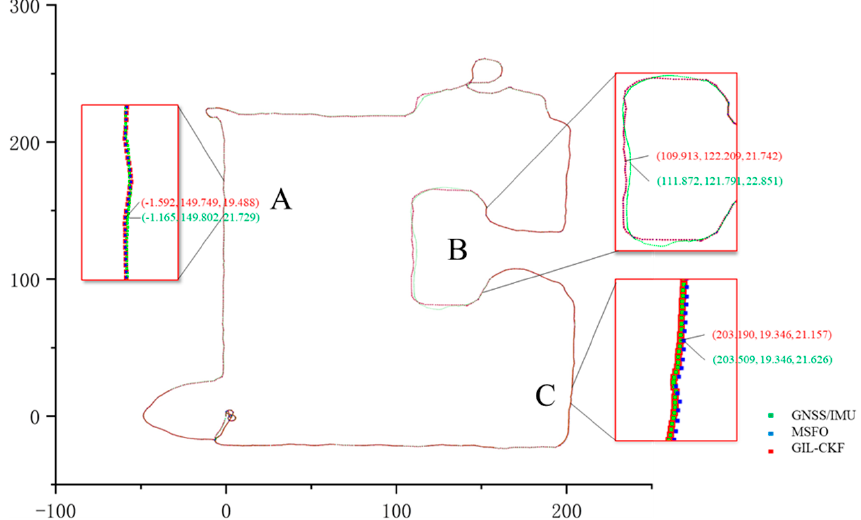
Figure 13. The trajectory of the scheme of factor graph and filter collaborative fusion (unit: meter). In the left part of the figure, because of the serious occlusion of trees and the poor state of the GNSS signal, the SO switches the update amount to MSFO. Select one of the adjacent points to compare (point A), the horizontal difference of 0.427 m, and the elevation difference of 2.241 m. In the middle of the figure on the right is a closed corridor; the GNSS signal is partially lost, and the SO switches to MSFO. Select a pair of adjacent points to compare (point B); the horizontal difference is 1.959 m, and the elevation difference is 1.109 m. In the lower right corner of the figure, the carrier enters the open area. The scene is filtered to determine and switch to a better GNSS track. At the same time, due to the accumulation of errors in the SLAM system, MSFO continues to deviate from GNSS. One pair of adjacent points is selected for comparison (point C). The lateral distance is 0.319 m, and the elevation difference is 0.469 m. This situation is corrected by reaching the middle right. In most open areas, thanks to the high robustness of MSFO, the difference between the GNSS and MSFO trajectories is so small that they appear to fit